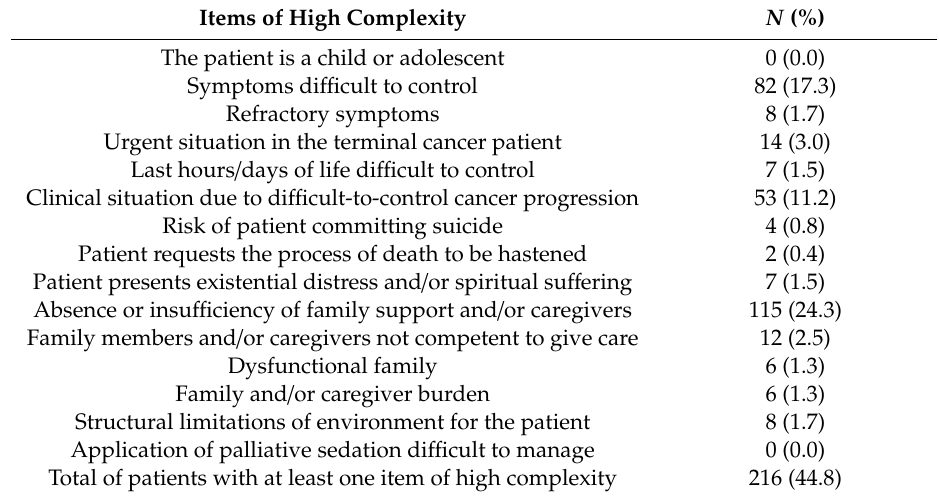
Table 2. Number of patients with a highly complex situation, according to the Diagnostic Instrument of Complexity in Palliative Care (IDC-Pal ©